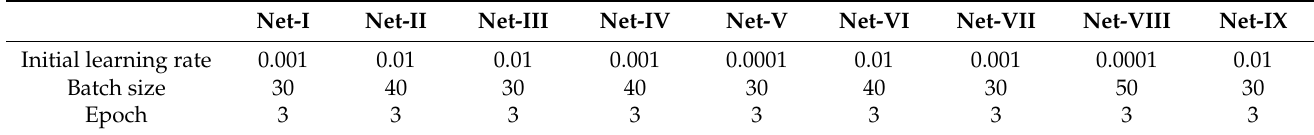
Table 10. Optimal training hyperparameters for nine CNN models.